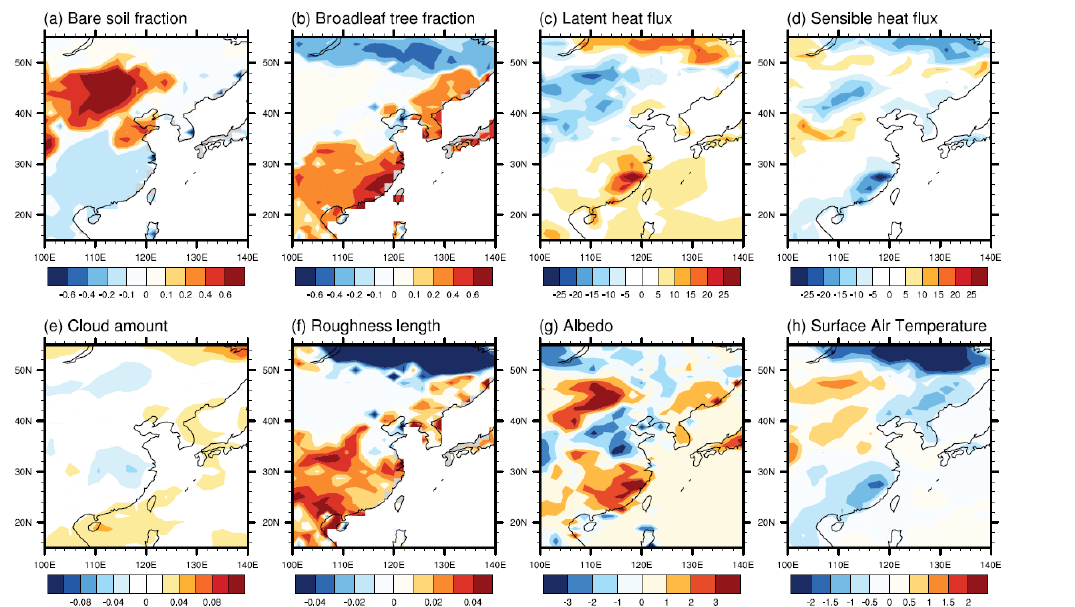
Figure 7. AEnod − Anod in JJA showing the applied fractional land cover changes and their impact in (a) bare-soil fraction, (b) broadleaf tree fraction, (c) latent heat flux (Wm − 2 ) , (d) sensible heat flux (Wm − 2 ) , (e) cloud amount (fraction), (f) roughness length (m), (g) albedo (%) and (h) surface air temperature